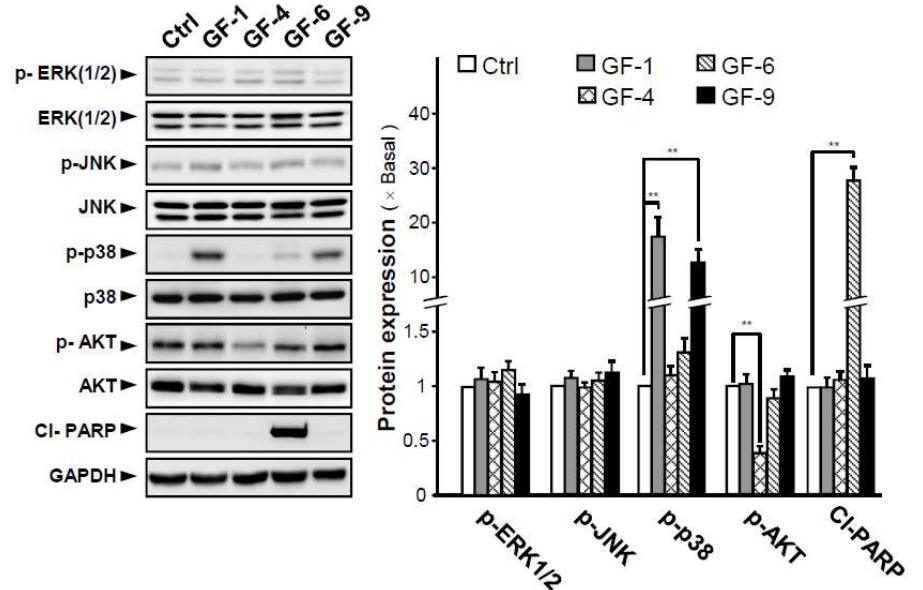
Figure 5. The G. uralensis flavoniods induce signaling of ERK (1/2), JNK, p38, AKT, and PARP. B16-F10 cells were treated with selected flavonoids (GF-1, 4, 6,and 9) at concentration of 40 μM or with medium (0.1% DMSO) for 48 h. Cell lysates were analyzed by Western blotting with the indicated antibodies (left panel). Photographs of the chemiluminescent detection of the blots, which were representative of three independent experiments, are shown (right panel). The relative abundance of each band to their own GAPDH was quantified, and the control levels were set at 1.0. Data are expressed as percentage of control, in means ± SEM ( n = 3). ** p < 0.01, compared with control.